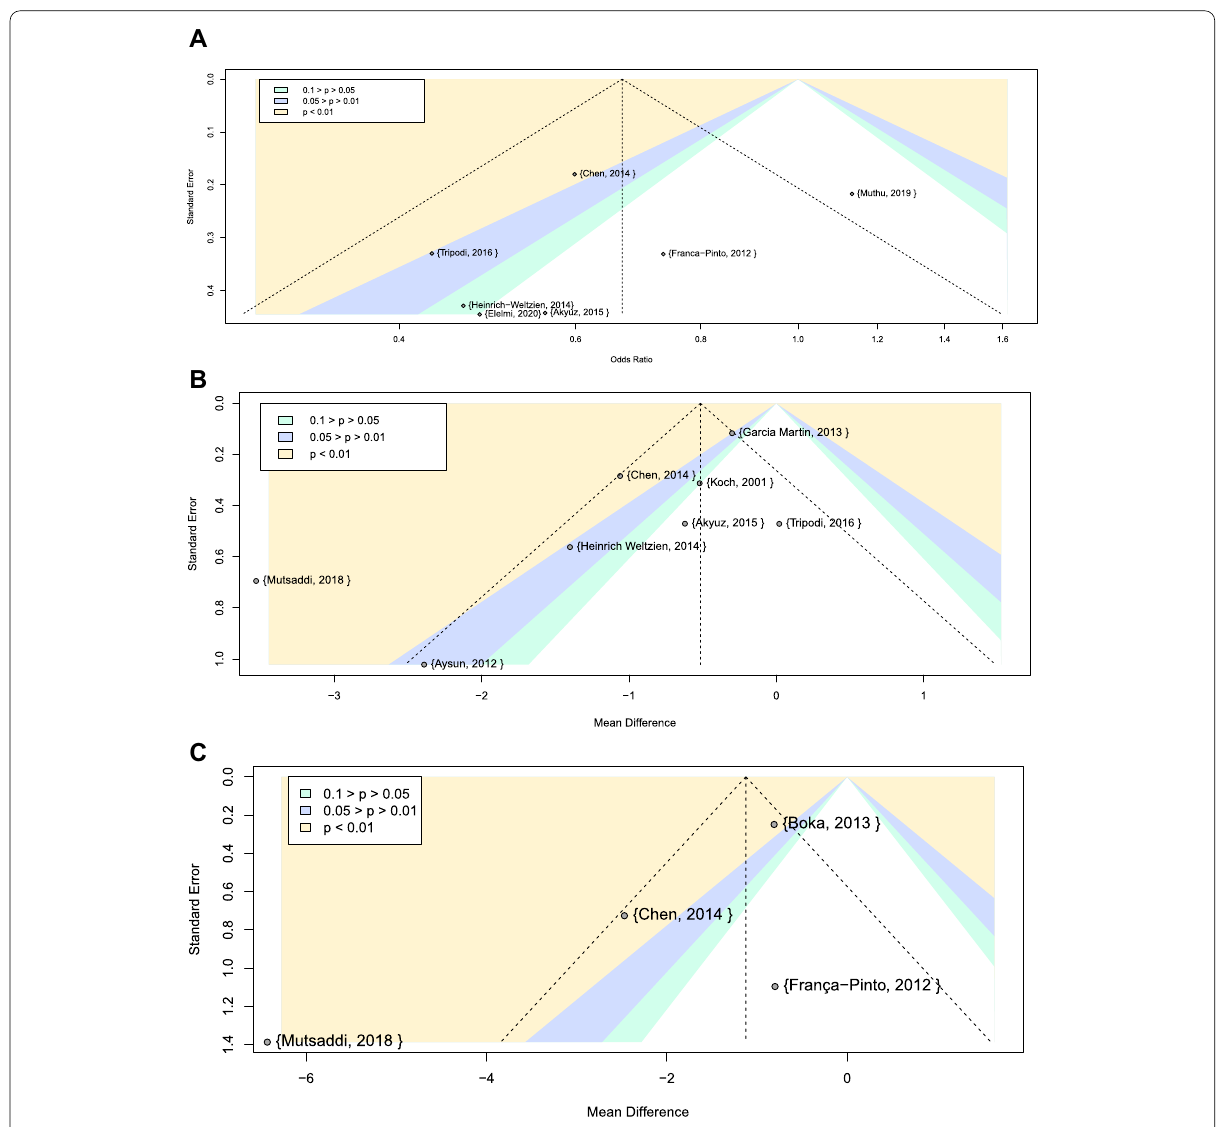
Fig. 5 Contour-enhanced funnel plot A Caries development B Tooth-level C Surface